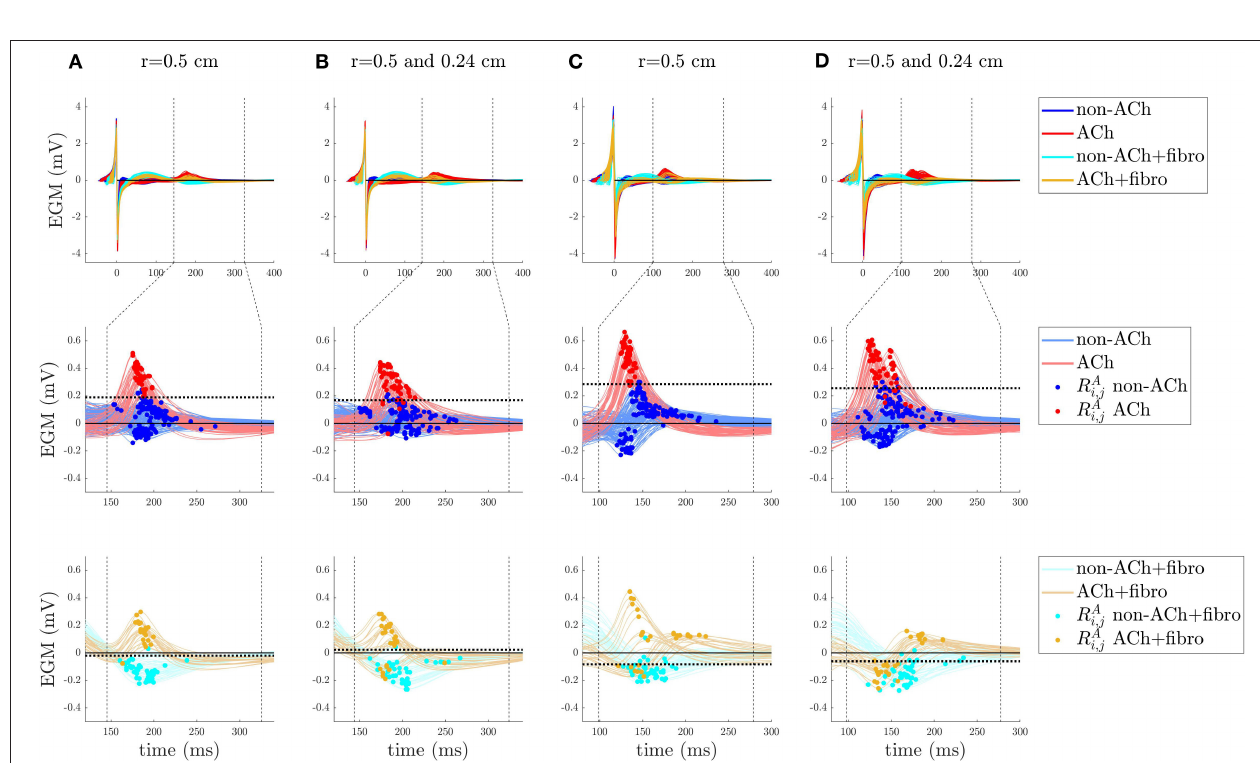
FIGURE 6 | EGM analysis for a PxAF tissue with 20% non-uniform diffuse type 1 fibrosis in (A,B) and a PsAF tissue with 40% type 1 Fnu in (C,D) (type 1 Fnu is represented in Figure 1E ) cases. Top row: EGMs aligned with respect to the time correspondent to the maximum slope of the depolarization wave (marked as t = 0 in the x -axis). The vertical dashed lines delimit the time window TW for the R i , j ( t ) repolarization signals. Bottom rows: atrial repolarization waves, R i , j ( t ), with dots indicating the maximum absolute value R A i , j of the waves within TW. The horizontal dotted lines represent the optimal threshold R th found by Se/Sp analysis.